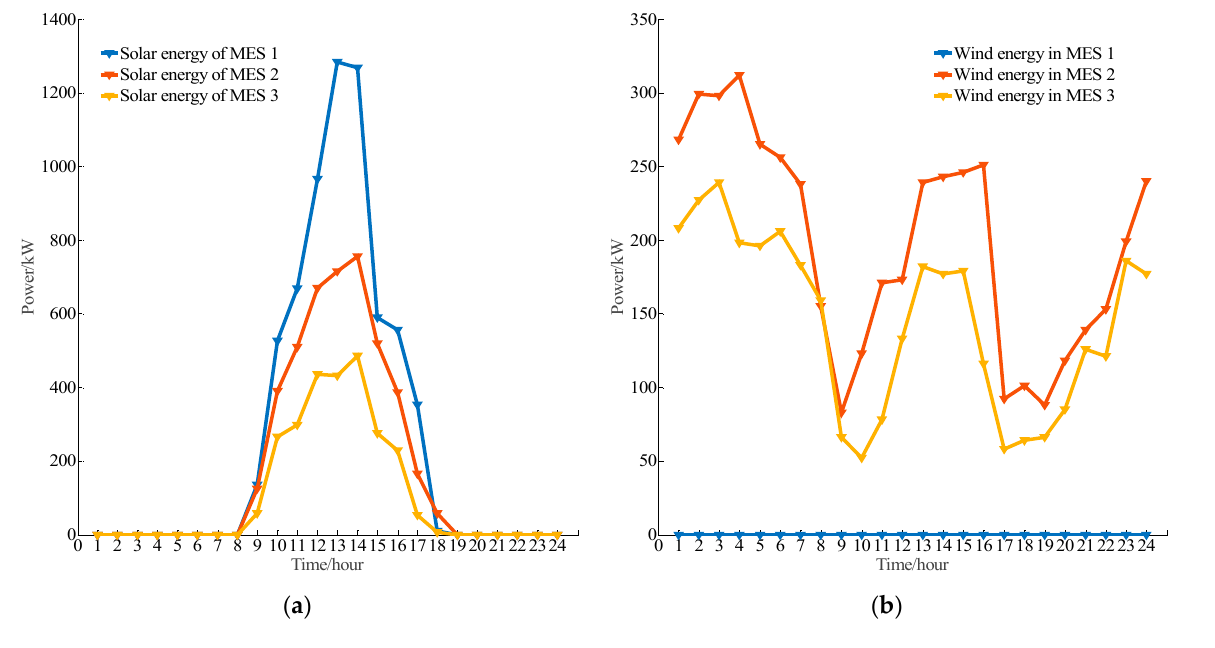
Figure A2. PV and wind energy power output in each subsystem: ( a ) solar energy in each MES; ( b ) wind energy in each sub-MES.